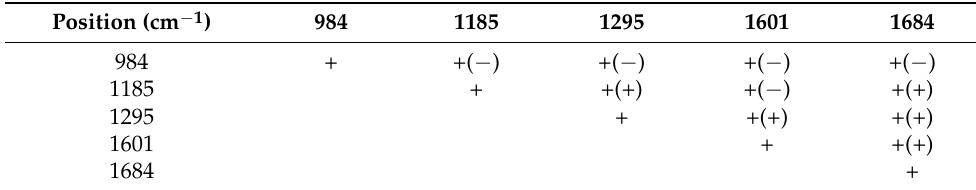
Figure 2. 2D-COS analysis at wavelengths of 3600–2800, 1800–900, and 900–700 cm − 1 for the PA synchronous ( a , c , e ) and asynchronous ( b , d , f ) spectra. Red and blue areas represent positive and negative correlation values, respectively, whereas the white area represents zero correlation values. Table 2. 2D-FTIR-COS results on the assignment and sign of each cross-peak in synchronous and asynchronous maps of PA samples at different temperatures (1800–900 cm − 1